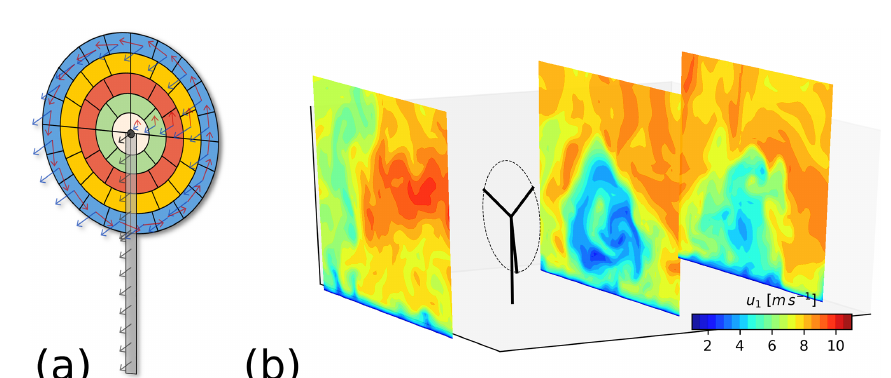
Figure 1. (a) Schematic representation of the ADM-R model used in the WTM. Arrows denote the direction of the forces acting on the flow. (b) Example of a wake simulated with PALM-WTM. Shown is the instantaneous wind speed in mean flow direction ( u component, inflow from the left).